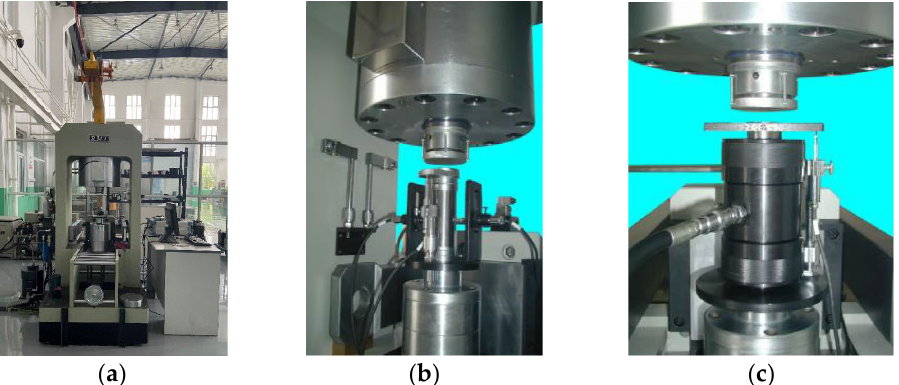
Figure 2. Mechanical experimental equipment. ( a ) Experimental equipment; ( b ) Triaxial compres- sion tester; ( c ) Uniaxial compression tester. tester; ( c ) Uniaxial compression